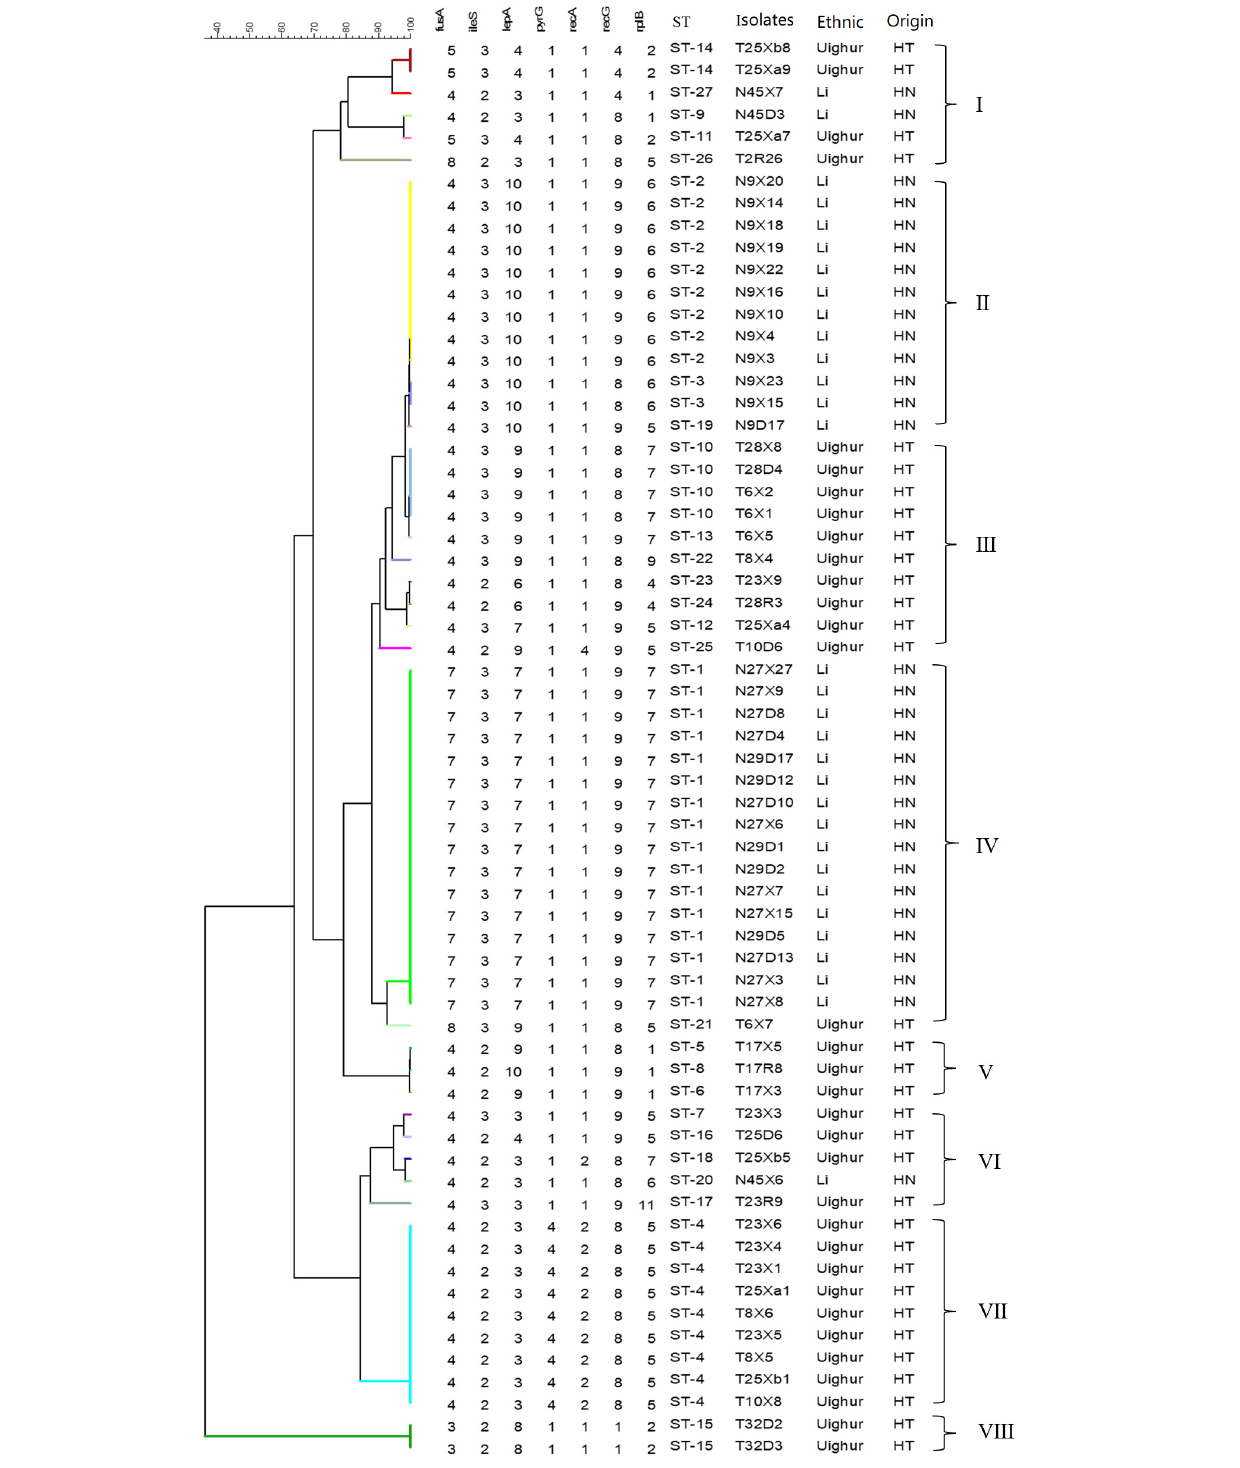
Frontiers in Microbiology |